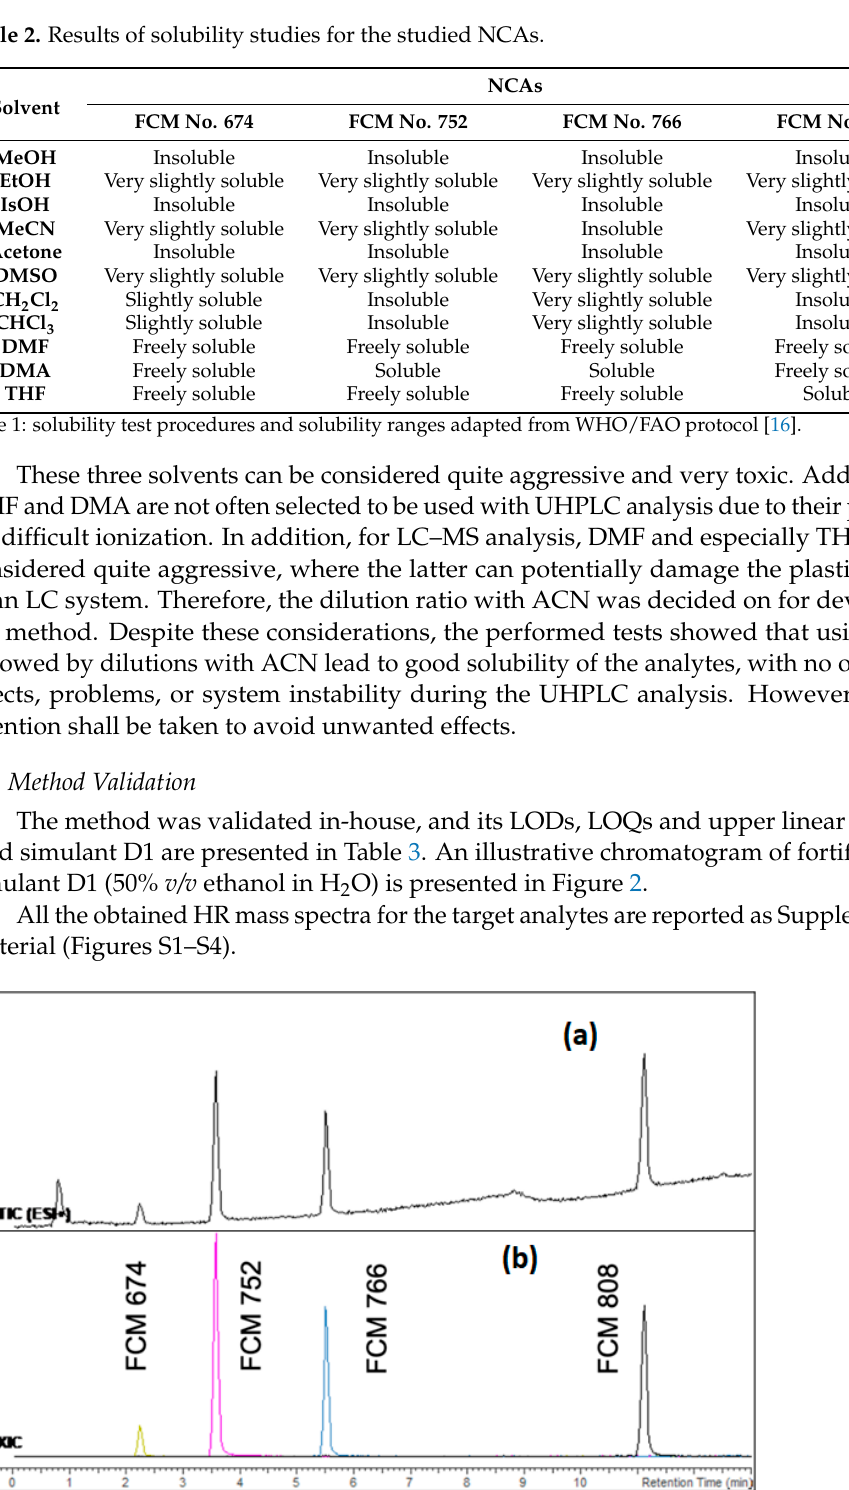
Table 3. Analytical features of the validated analytical method.